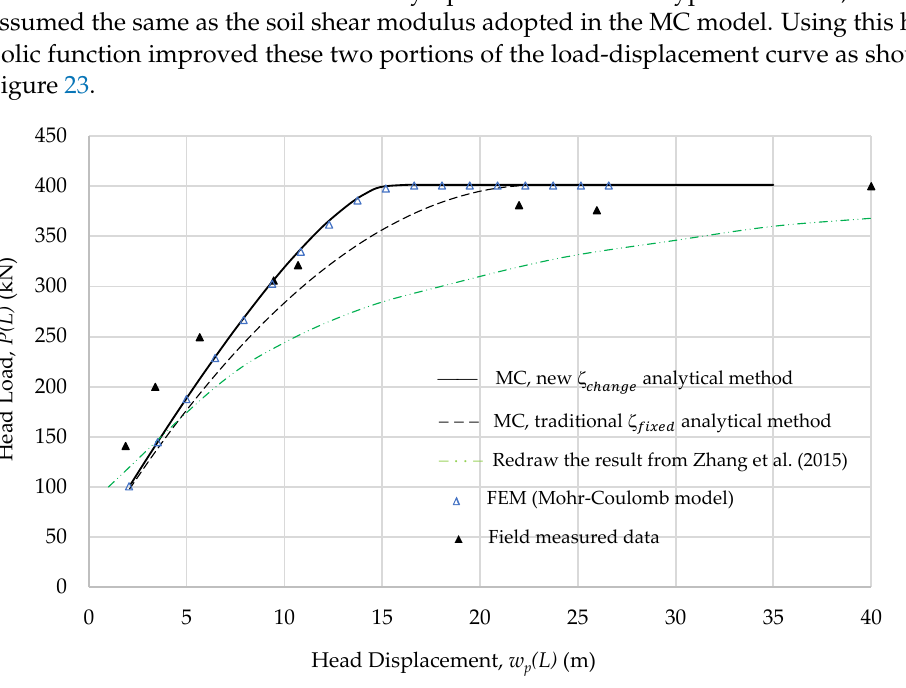
Figure 22. Load–displacement curve at the pile head in the case study P1 of Sowa [28].